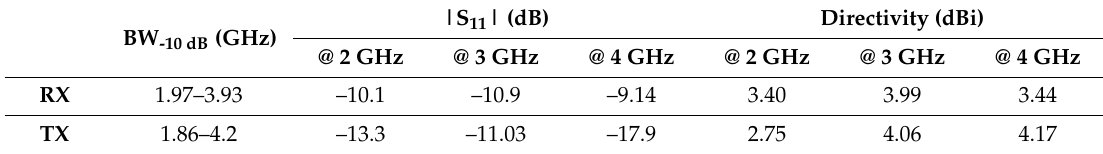
Table 2. Numerical results achieved for the RX and the TX tag